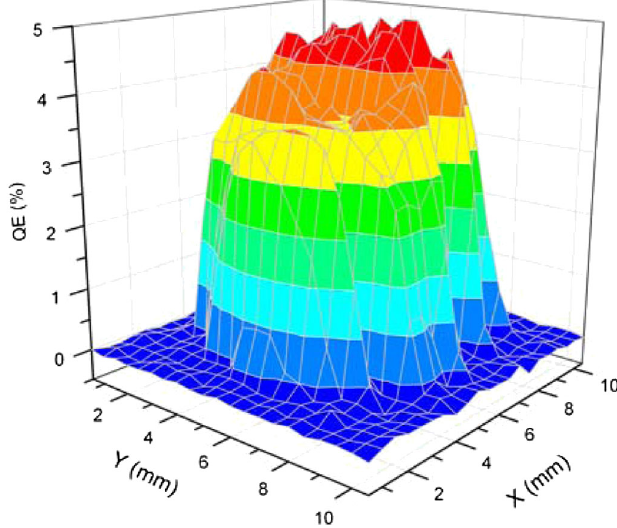
FIG. 3. (Color) QE scanning map for cathode #310309Mo done in the preparation chamber.